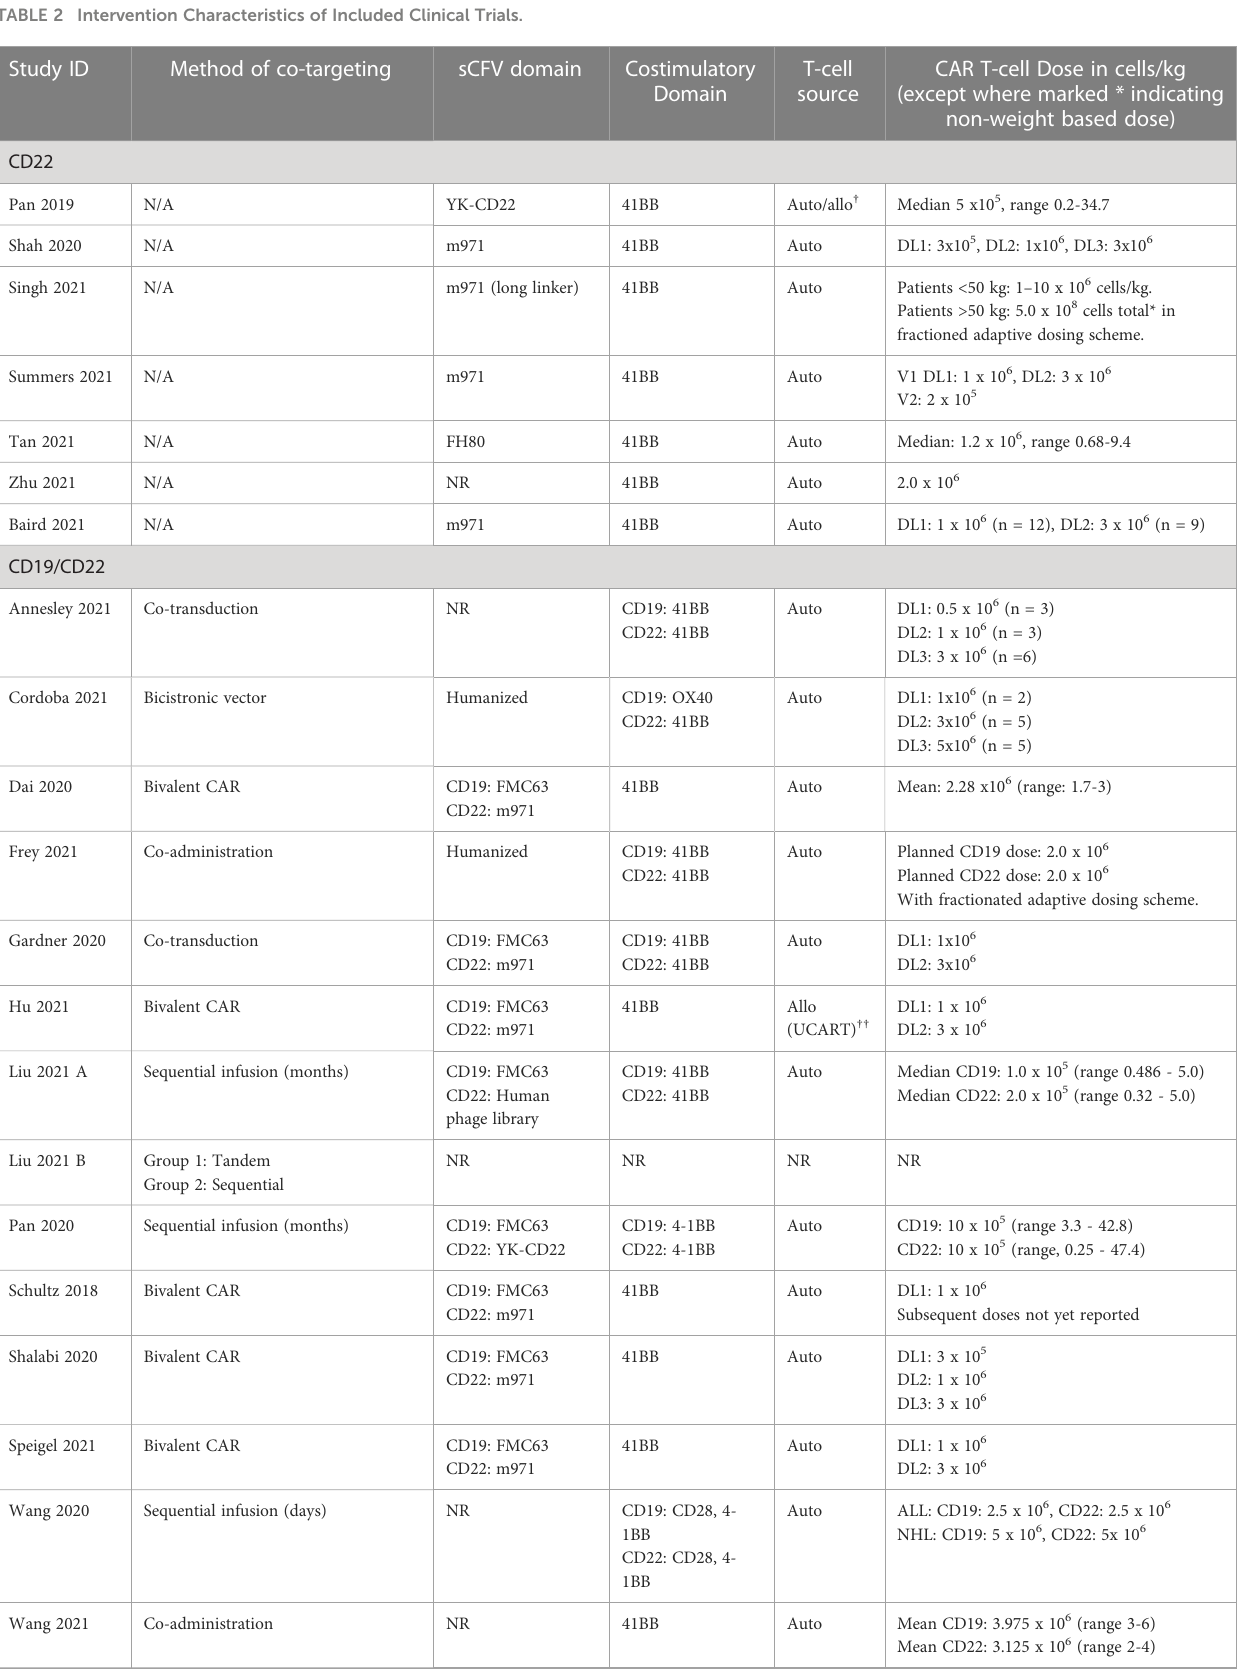
TABLE 2 Intervention Characteristics of Included Clinical